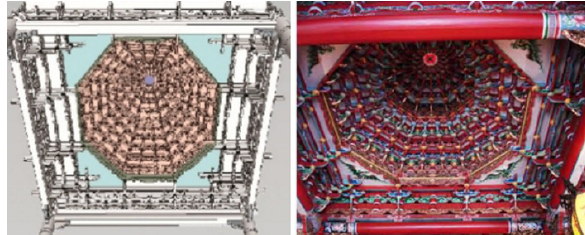
Fig 7. Object Models, Revit Fig 8. SketchUpmodel of caisson (left), photograph